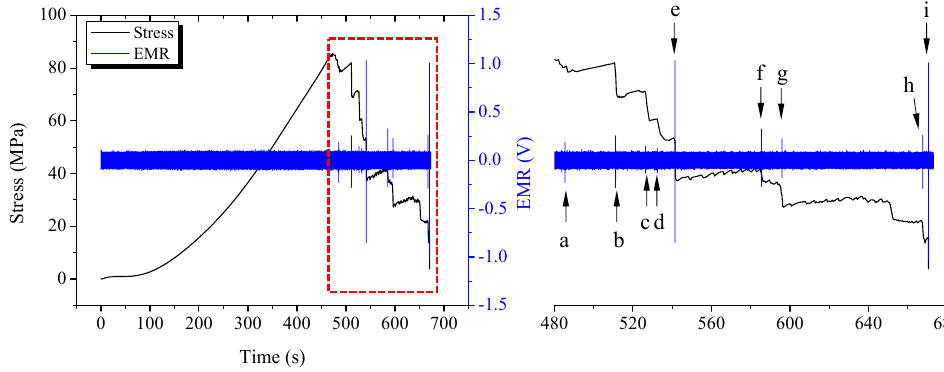
Figure 13. Stress curve and EMR signal of the rock sample under loading.